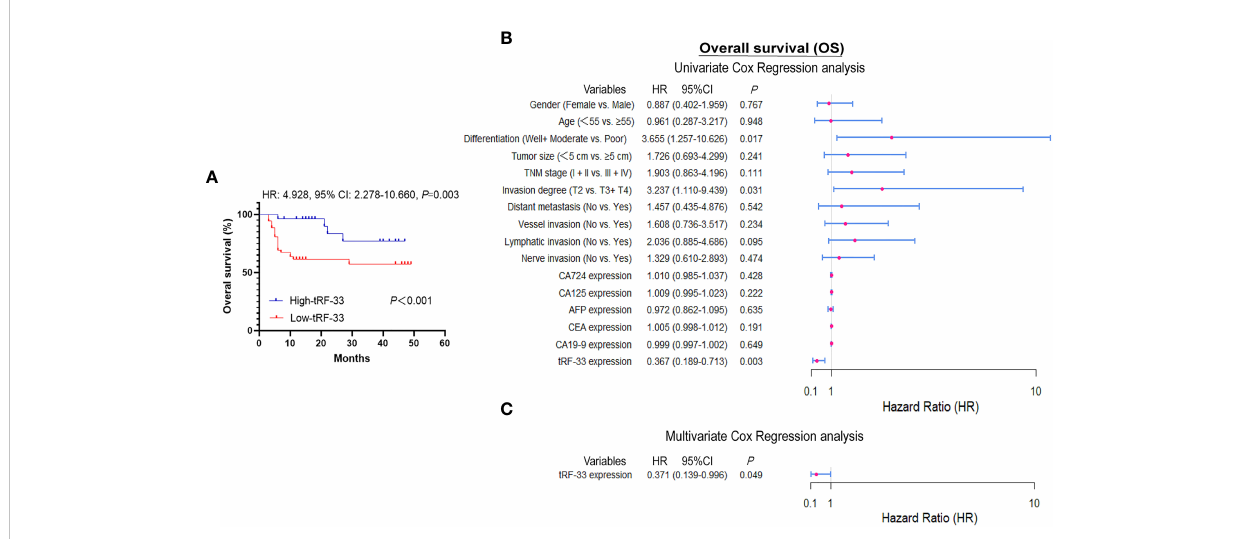
FIGURE 3 Diagnostic values of tRF-33-P4R8YP9LON4VDP. (A) Kaplan – Meier survival curve based on tRF-33 levels and overall survival (OS) of advanced gastric cancer (AGC) patients. (B, C) Forest plots of the univariate and multivariate Cox proportional regression analysis for OS in the AGC